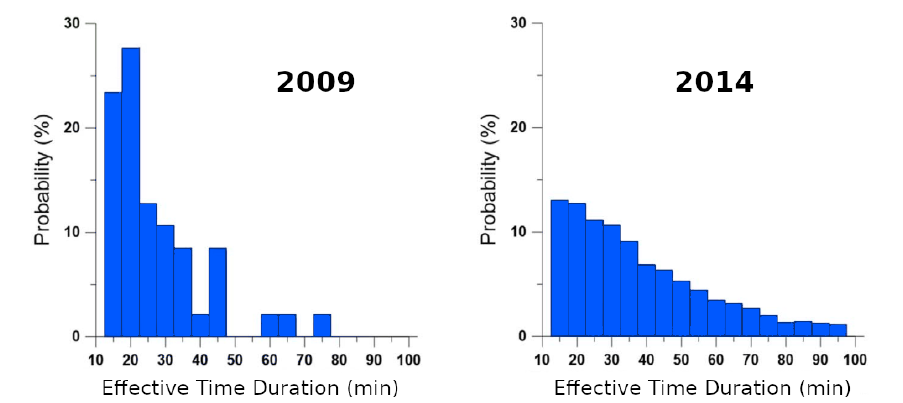
Figure 19. Probability to detect equatorial plasma bubbles (EPBs) with a particular effective time duration, for both years studied in Reference [19]: 2009 ( left ) during solar minimum and 2014 ( right ) during the last solar maximum (adapted from Reference [19]).